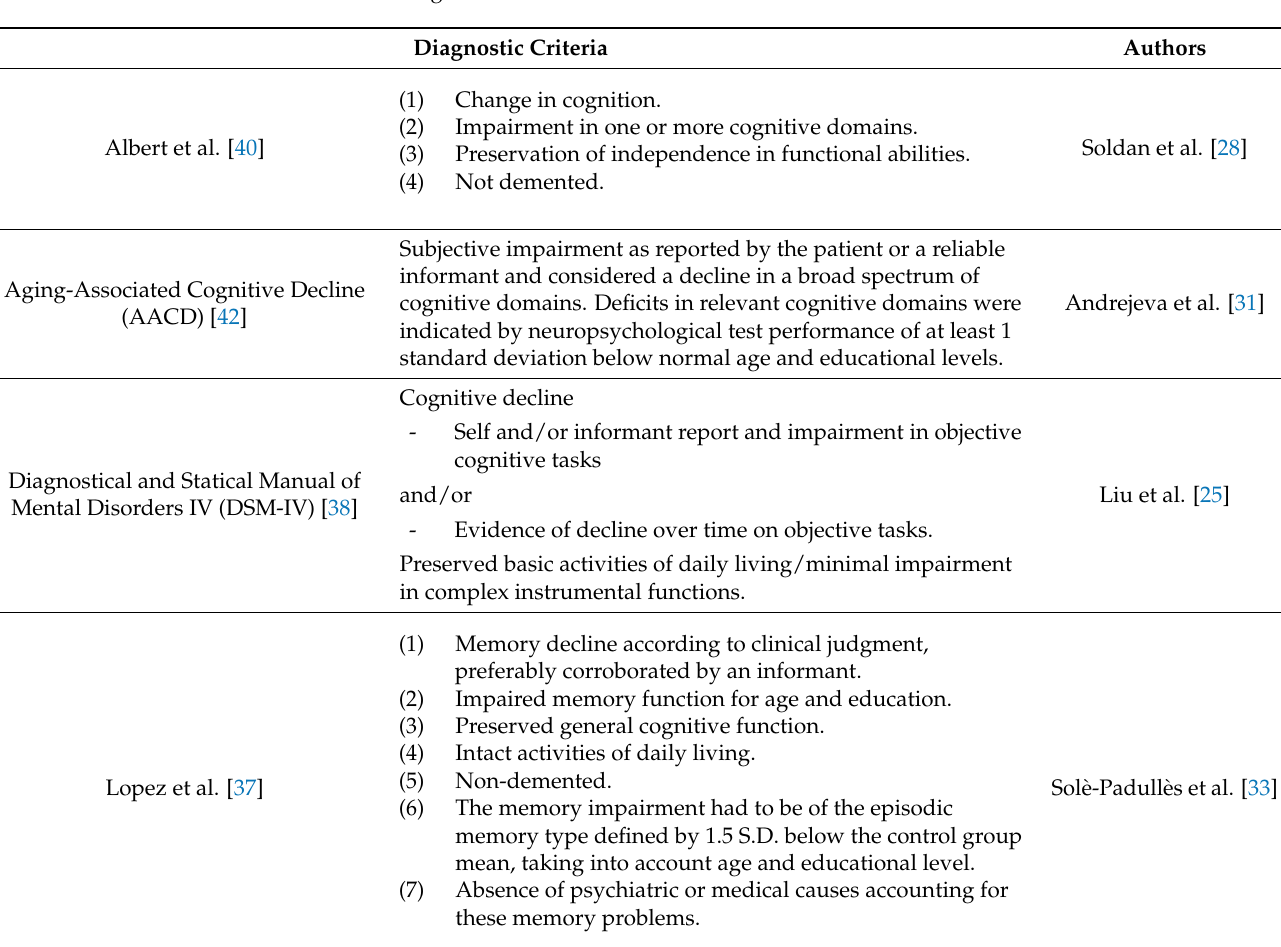
Table 4. Diagnostic